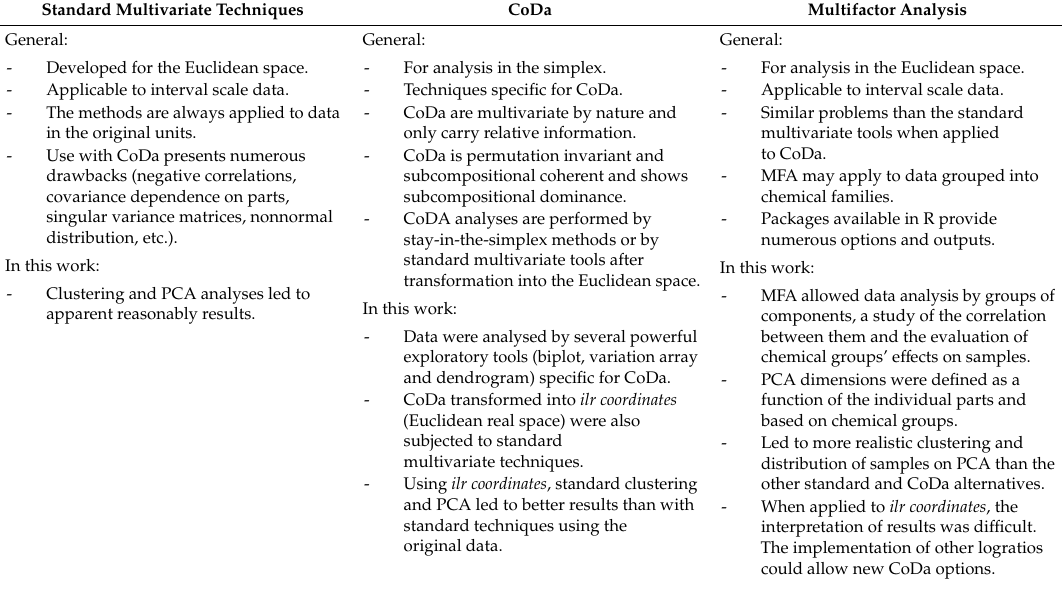
Figure 8. A study, based on the original data, of the changes according to processing phases and extraction method in the minor components in green Spanish-style fat using Multiple Factor Analysis (MFA): PCA was done according to minor component groups. Partial clouds were according to groups of compounds ( A ), and hierarchical clustering was done on a factor map ( B ). GT0, GT2 and GT3 are oils extracted from the fresh, fermented and packaged olives, respectively. Samples coded S were extracted by Soxhlet; otherwise, they were extracted by Abencor. See Table 1 for other abbreviations. Table 3. Main characteristics of the standard multivariate statistics, compositional data (CoDa) and multifactor analysis. Standard Multivariate Techniques CoDa Multifactor